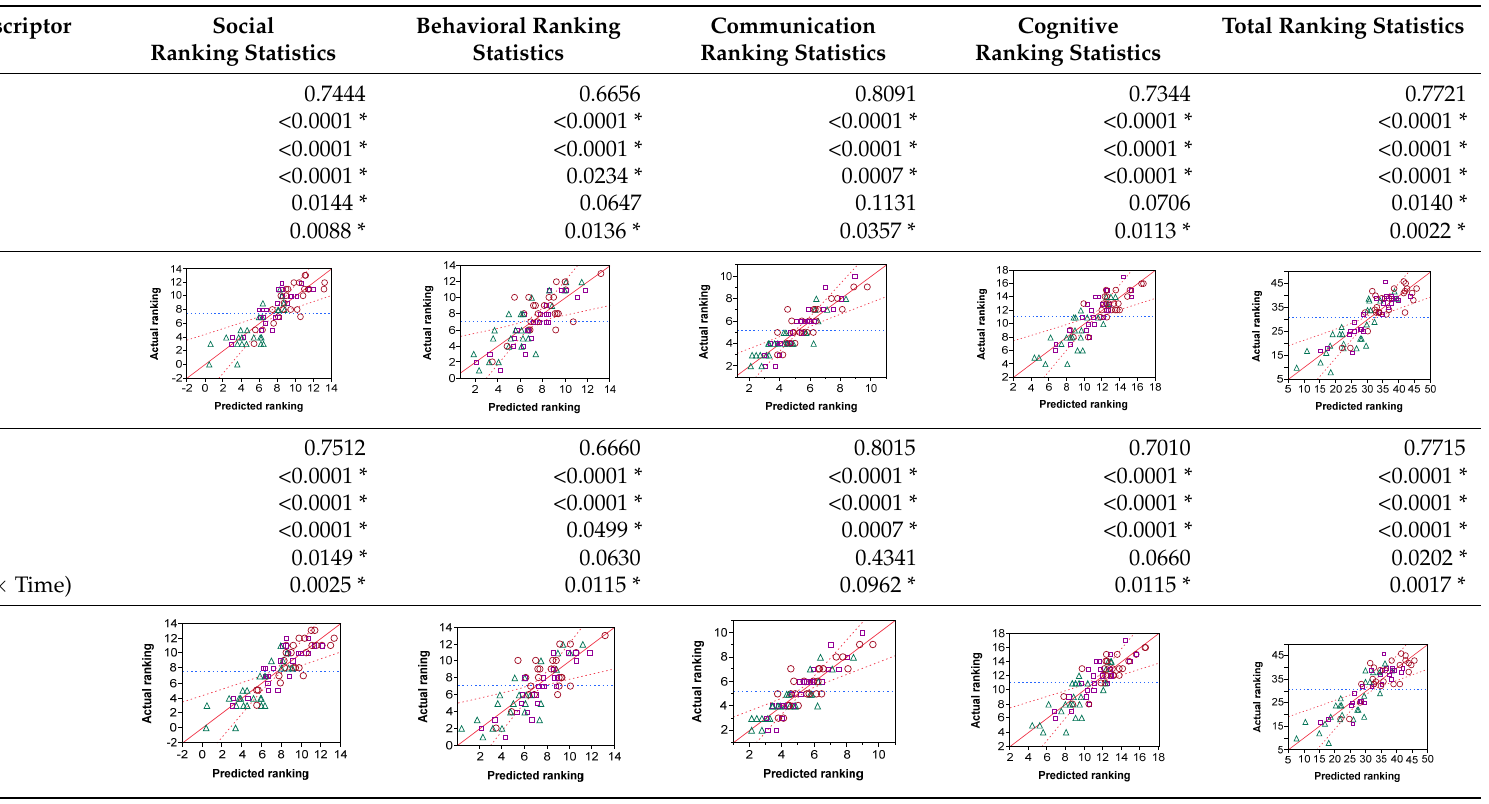
Table 4. Linear mixed model effects between partial rankings (or total ranking) and monitored biochemical parameters (Bio = GSH, GSH/GSSG), treatment time (Time), and cross effects (Bio × Time). Index of determination (R 2 ) and statistical significance of the whole model p(Model) and individual regression coefficients p(Intercept), p(Bio), p(Time), p(Bio × Time) were determined for each combination of biochemical regressor and psychological outcome parameter. Statistical significance for p < 0.05 is indicated with the * asterisk symbol. The related diagrams display a level of agreement between the predicted and experimental values.